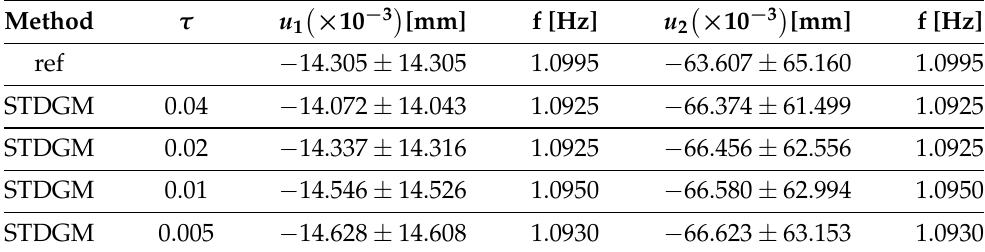
Table 1. Comparison of the position of point A for the reference and STDGM results with decreasing time step τ , for the St. Venant–Kirchhoff model. The displacements u 1 and u 2 are written in the format “ mean value ± amplitude ” and frequency. The row marked by ”ref” shows the reference benchmark values published in [40].